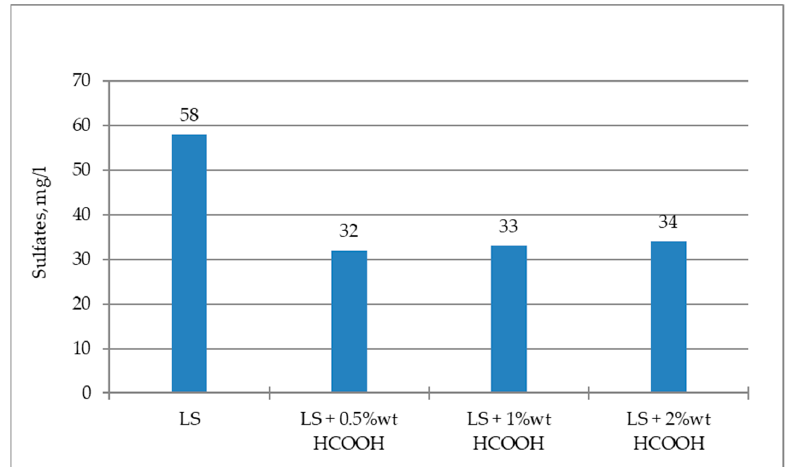
Figure 6. Sulfates in the washing bottle after flue gas cleaning.